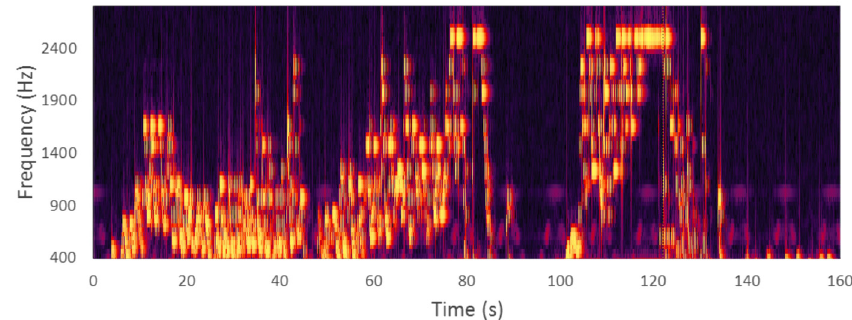
Figure 24: Time – frequency spectrum during three short masturbation episodes.